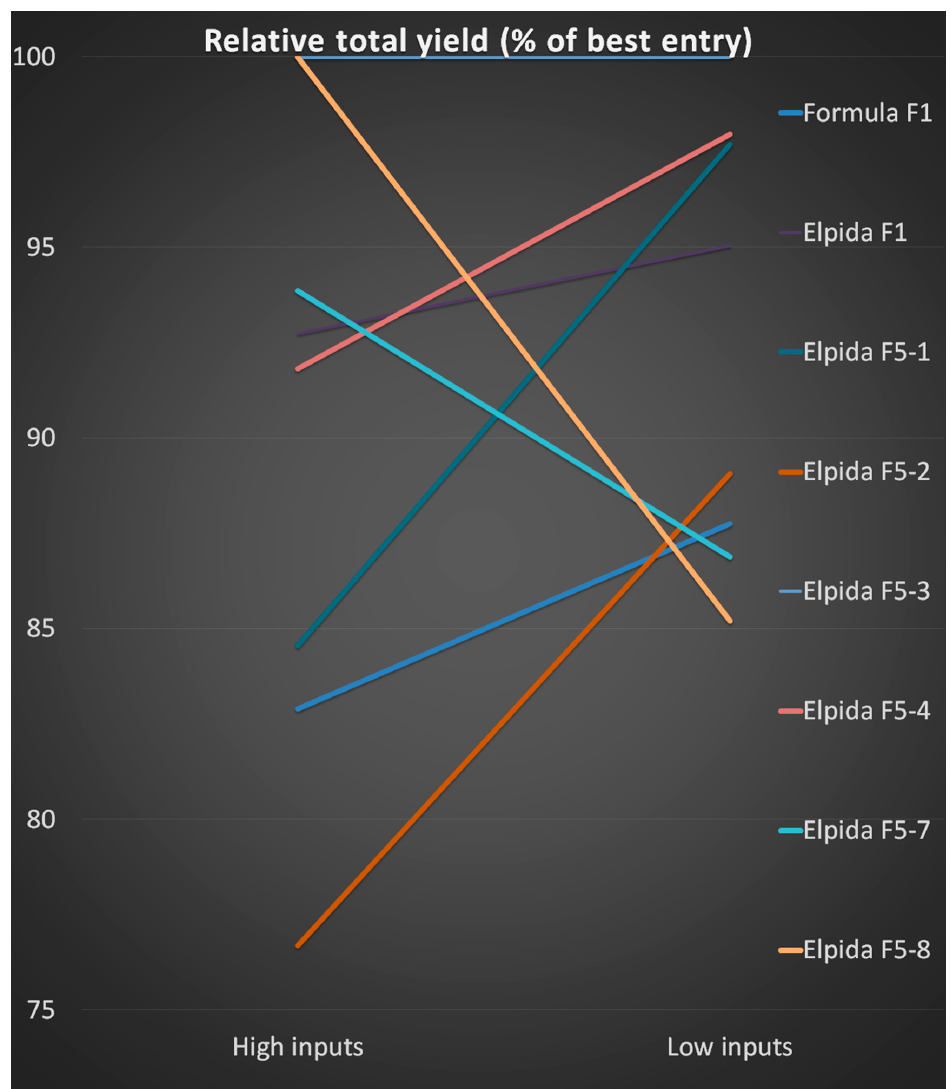
Figure 3. Relative total yield (as % of the best entry) of F 1 hybrids and recombinant inbred lines with high and stable performance in two different (high- and low- input) farming systems.